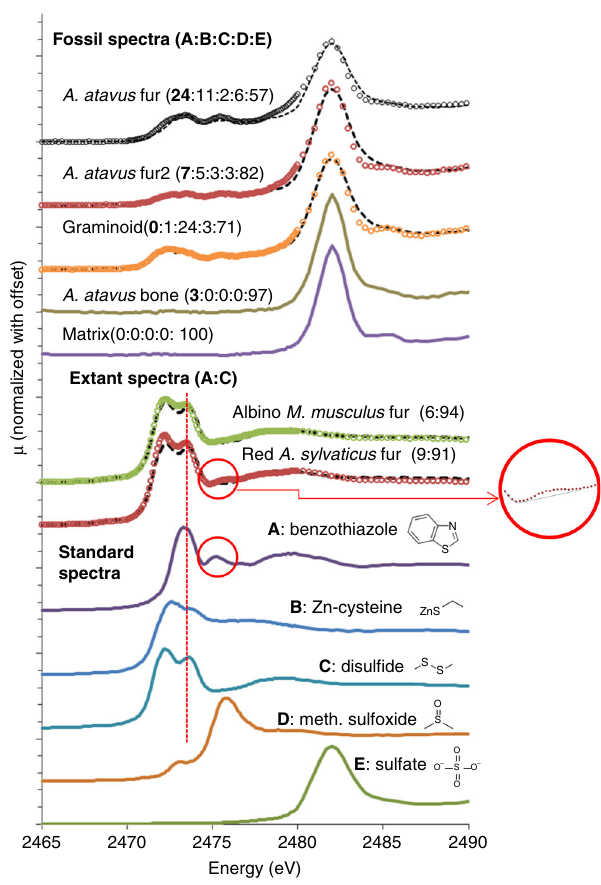
Fig. 3 Sulfur K-edge XANES data for standard, extant, and fossil specimens. The sulfur standards, A benzothiazole, a benzosulfur compound and a key component of pheomelanin, B Zn – cysteine, a terminal S organic functional group where we have substituted Zn for H as the exchangeable cation to simulate the con fi guration expected in pheomelanin tissue or its residue, C oxidized glutathione (disul fi de) comparator for the dominant sulfur component in keratin, D methionine sulfoxide, an oxidized form of organic sulfur, and E Zn sulfate. The two extant mice spectra are presented along with linear combination fi ts (dashed lines) computed as a binary benzothiazole/disul fi de system. The red circles highlight the resonance which is strong in the benzothiazole standard and which is resolvable in the red fur. The dashed vertical line furthermore indicates energy where the dominant benzothiazole peak is coincident with the second oscillation in the bifurcated disul fi de peak to subtly shift the intensity of that second peak relative to the fi rst — a shift that is discernible in the red fur but not the albino fur. Normalized spectra from the fossil are presented along with LCF fi ts calculated using all fi ve standards as possible components (ratios of each standard contribution to the fi ts are given as a set of fi ve numbers in parentheses). Because the fossil bone and sedimentary matrix are almost pure sulfate, for clarity fi ts have been omitted. Fits are shown as dashed lines for the three soft tissue shell (see Table 1 for coordination chemistry details. Supple- mentary Fig. 5 presents all the details of the EXAFS fi tting for each spectrum). The summed coordination numbers for the fi rst shell in the two fossil spectra are 5.6 and 5.3, implying that Zn is present in both sixfold and fourfold coordination. The O1 and O2 bond distances are consistent with these two coordination states, where the shorter oxygen bond lengths (i.e., 1.983 and 1.993 Å) imply fourfold oxygen coordination (ideal distance of 1.96 Å) and the longer bonds (i.e., 2.104 and 2.056 Å) are comparable with the range measured for Zn in sixfold oxygen coordination